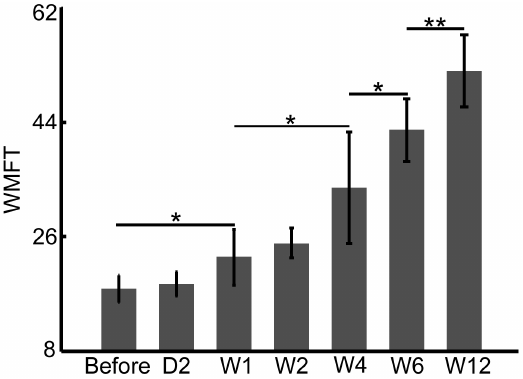
Figure 7. Statistical analysis of the Wolf Motor Function Test (WMFT) scores in stroke patients during six weeks of therapy (* p < 0.05; ** p < 0.01).